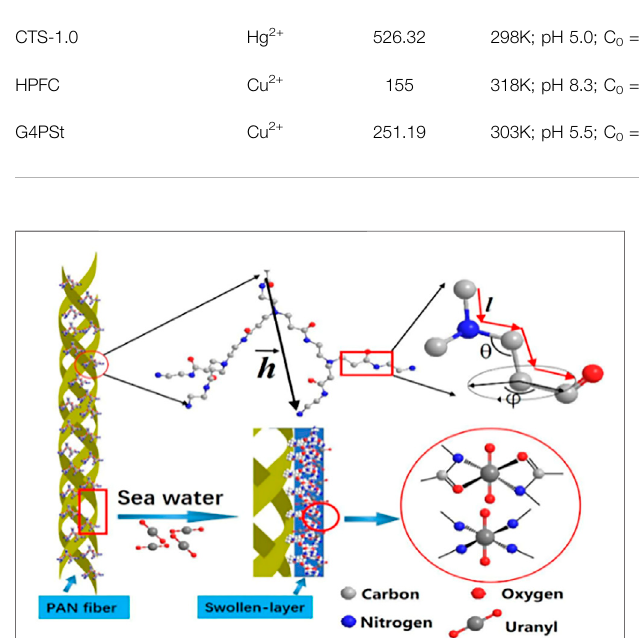
FIGURE 8 | Adsorption mechanism of U(VI) by PAN-nG-PAMAM.